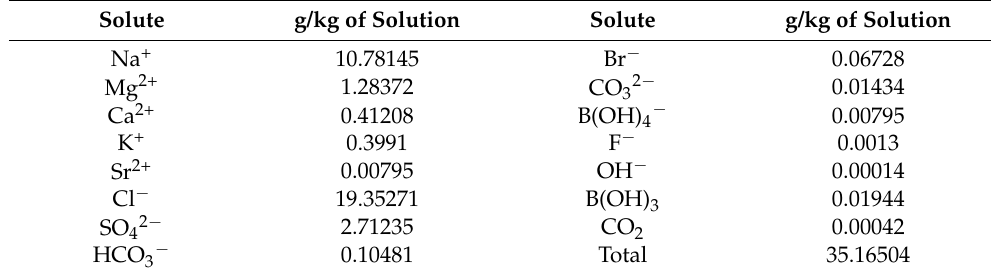
Table 2. Reference composition of seawater (data from [5]).